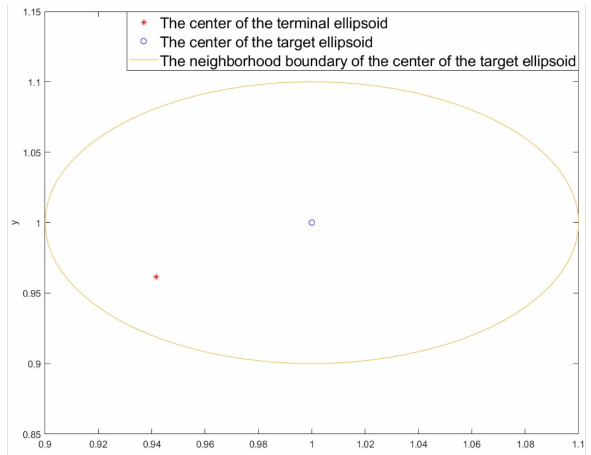
set with or without obstacle constraint.